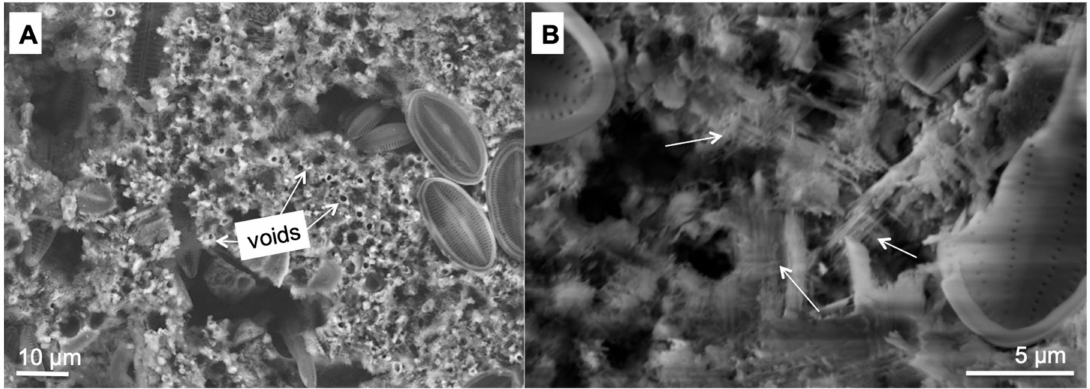
Figure 10. SEM images of ( A ) voids left by Oscillatoriaceae -like filaments and ( B ) elongated crystallite dendrites (white arrows) associated with the Oscillatoria casts.